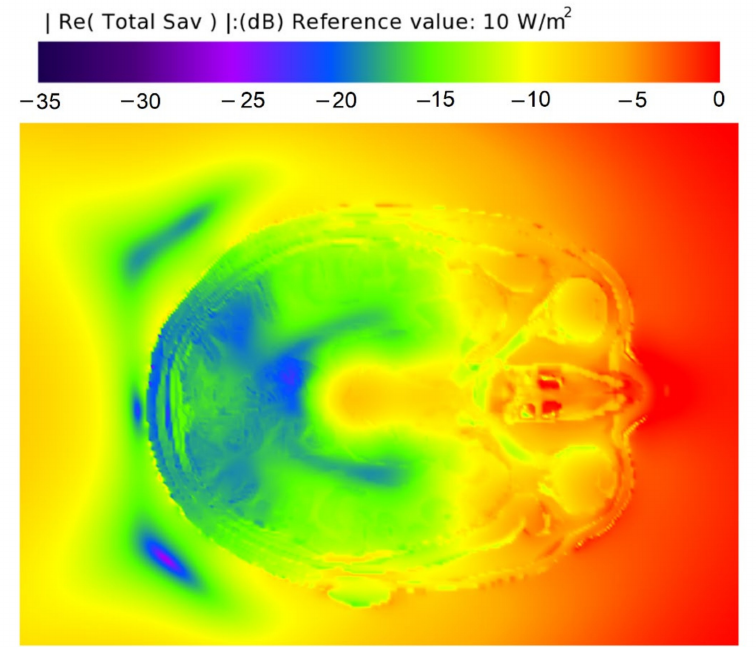
Figure 9. Power density for uncovered head, 750 MHz (in the logarithmic scale with reference value equal to 10 W/m 2 ).